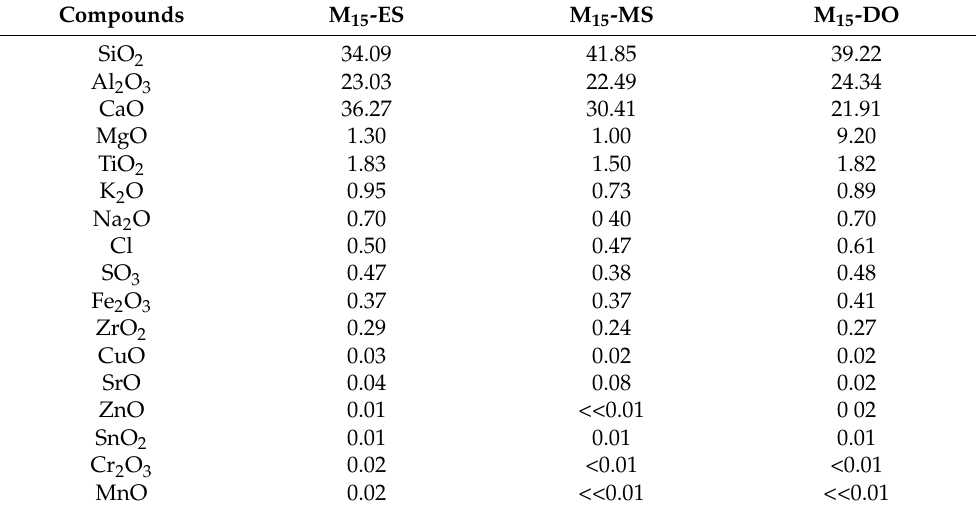
Table 3. Main composition of the glasses obtained after 15 min of exposure to concentrated solar energy (CSE) (XRF, expressed as oxides in wt.%; SD 0.02 wt.%). Compounds M 15 -ES M 15 -MS M 15 -DO SiO 2